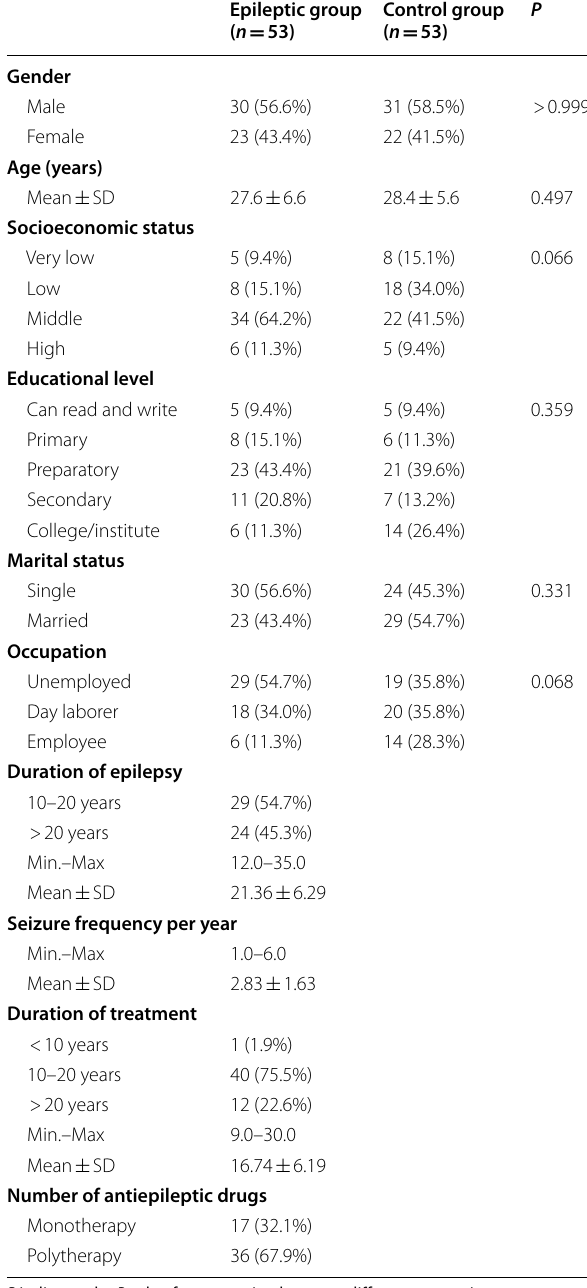
Table 1 Sociodemographic and epilepsy-related characteristics of the studied